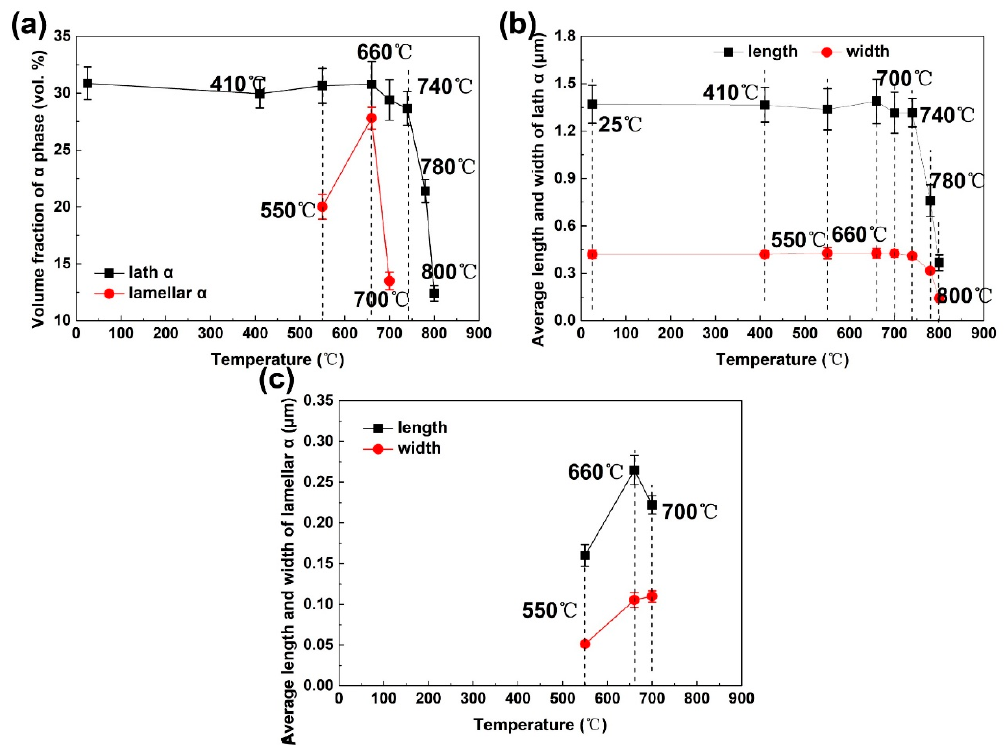
Figure 4. The variations of ( a ) volume fraction of lath and lamellar α phases, ( b ) average length and width of lath α , and ( c ) average length and width of lamellar α with temperatures.